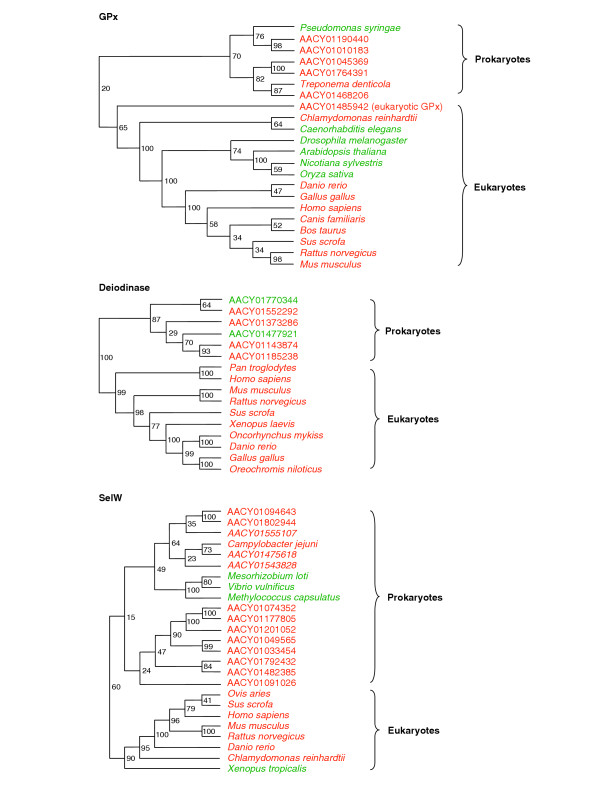
Phylogenetic analyses of deiodinase, GPx and SelW protein families. Selenoproteins are shown in red and Cys-containing homologs in green. The phylogenetic trees were generated by ClustalW and represented by Treeme.